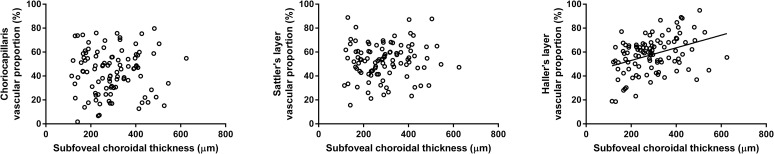
Relationship between subfoveal choroidal thickness and choroidal vascular proportion of en face images.(A) The choriocapillaris (r = 0.013, P = 0.901) and (B) Sattler’s layer (r = 0.079, P = 0.436) had no statistically significant correlation. (C) The vascular proportion of Haller’s layer (r = 0.383, P < 0.001) was directly proportional to the subfoveal choroidal thickness (Pearson product-moment correlation coefficient test).